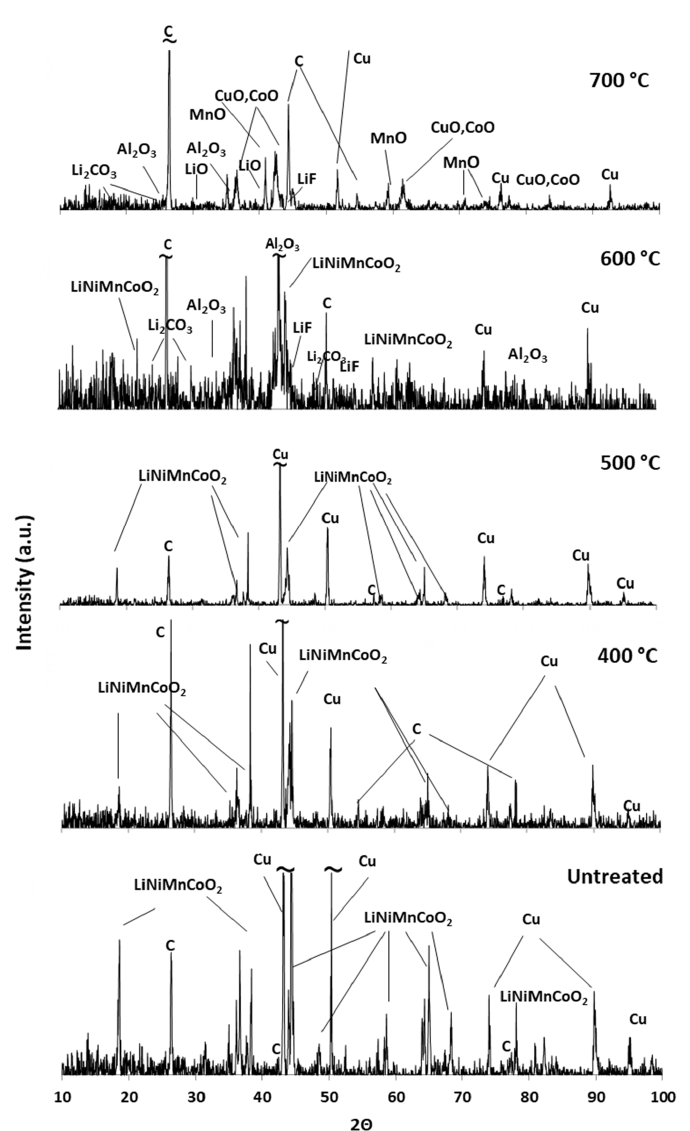
Figure 6. XRD diffractogram of residue after leaching pyrolyzed samples.